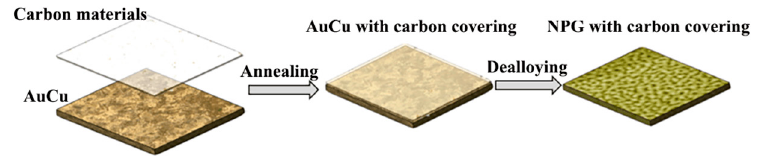
Figure 1. Diagrammatic sketch of carbon ‐ assistant nanoporous gold fabrication